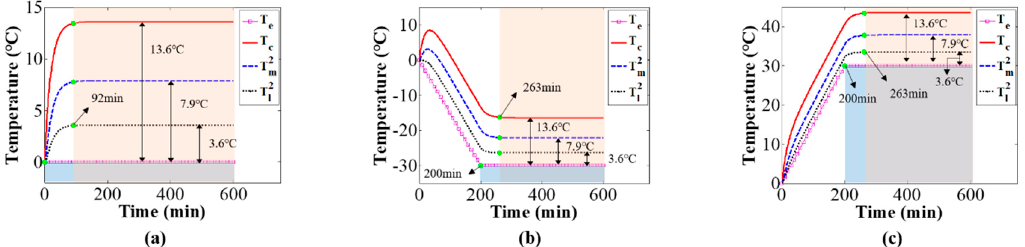
Figure 12. Effect of environmental temperature on the thermal equilibrium time and thermal equilibrium temperature: ( a ) T e = 0, ( b ) T e =